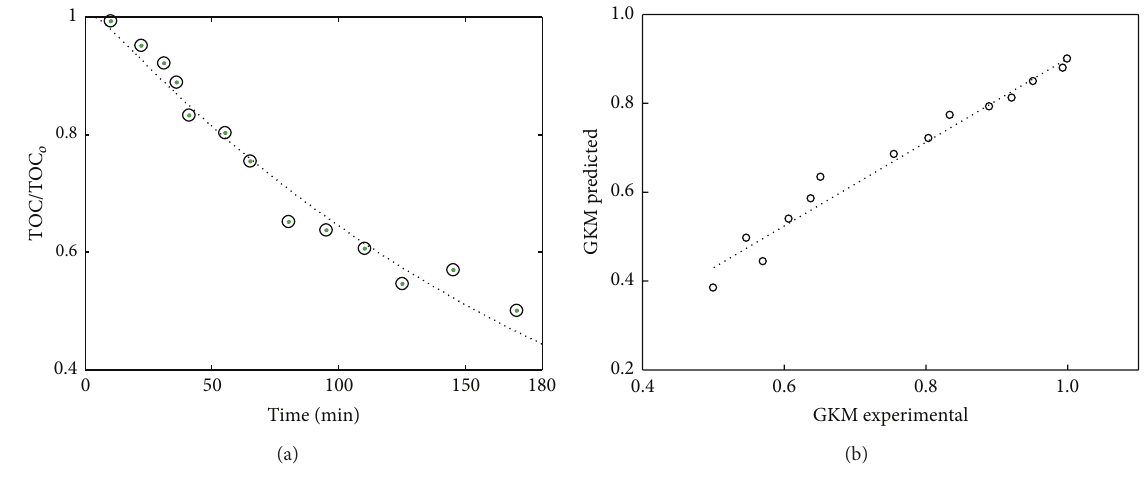
Figure 3: Plots for GKM (a) kinetic and (b) predicted versus